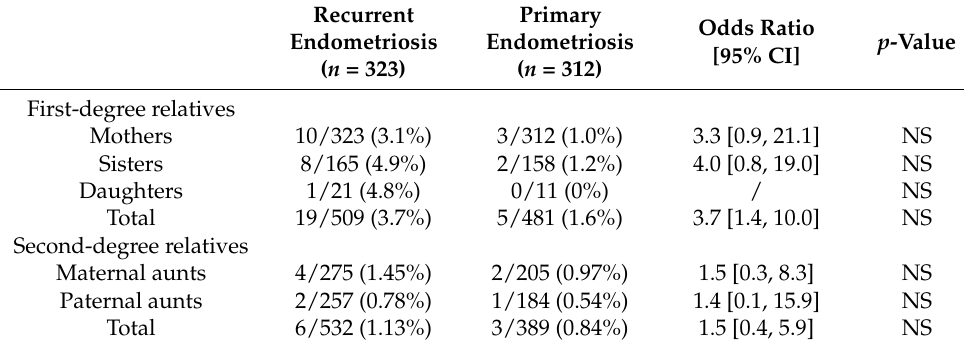
Table 3. Incidence of endometriosis in first- and second-degree relatives of recurrent and primary